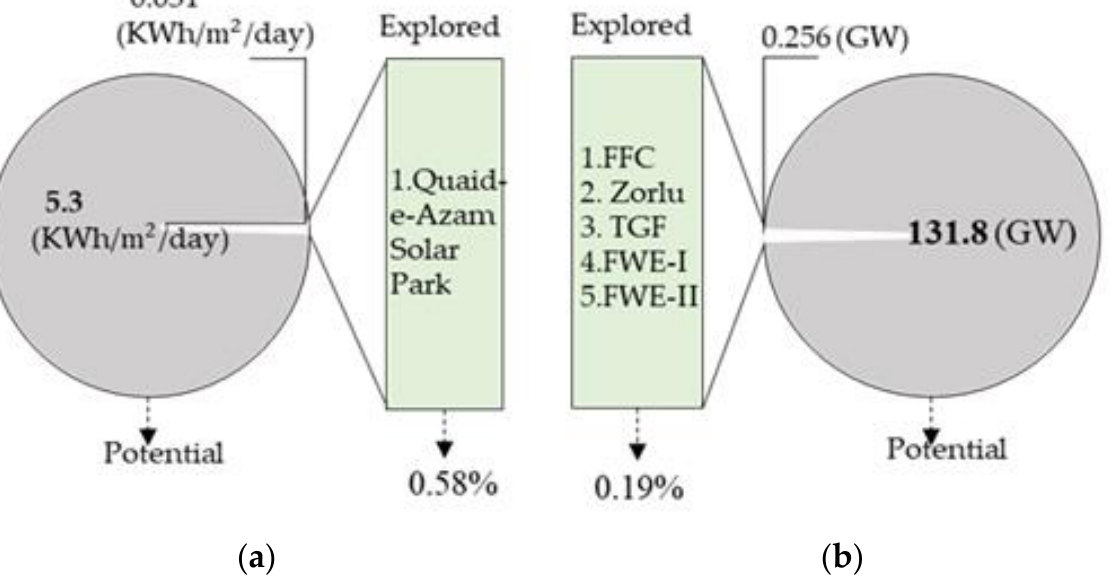
Figure 2. ( a ) Solar Energy in Pakistan [36]. ( b ) Wind Energy in Pakistan [51]. FFC — Fauji Fertilizer Company; TGF — Three Gorges First; FEW — Foundation Wind Energy.